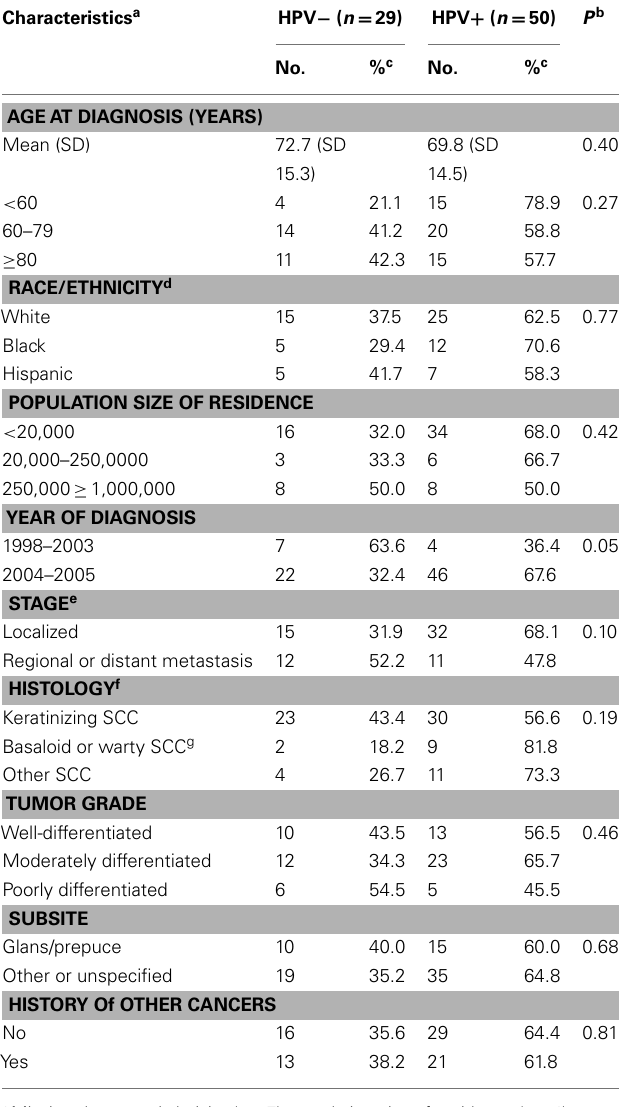
Table 1 | Genotype distribution of HPV DNA-positive invasive penile cancer cases ( n = 50).